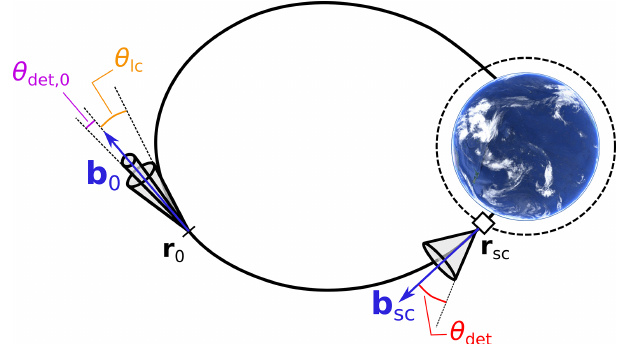
Figure 2. Geometry used in the derivation of directional differential flux of precipitating